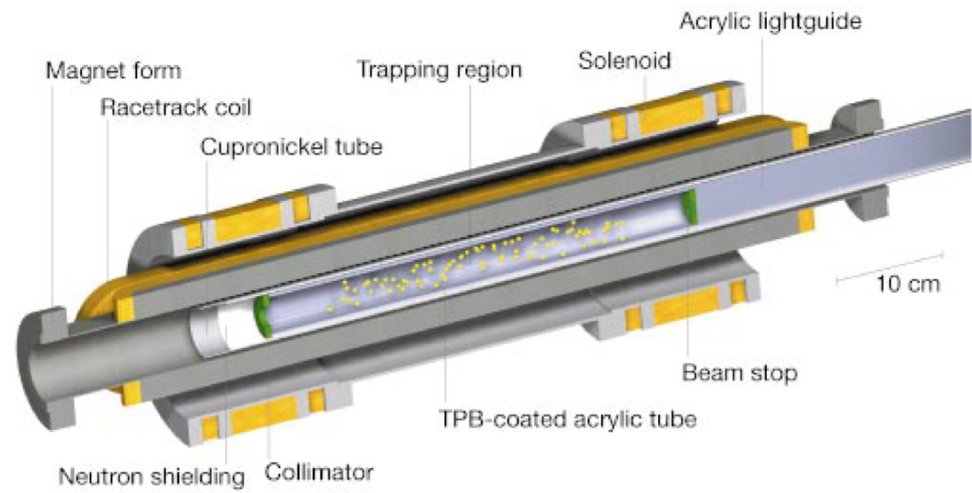
Figure 4. Ioffe-type magnetic trap at NIST. Taken from Ref.